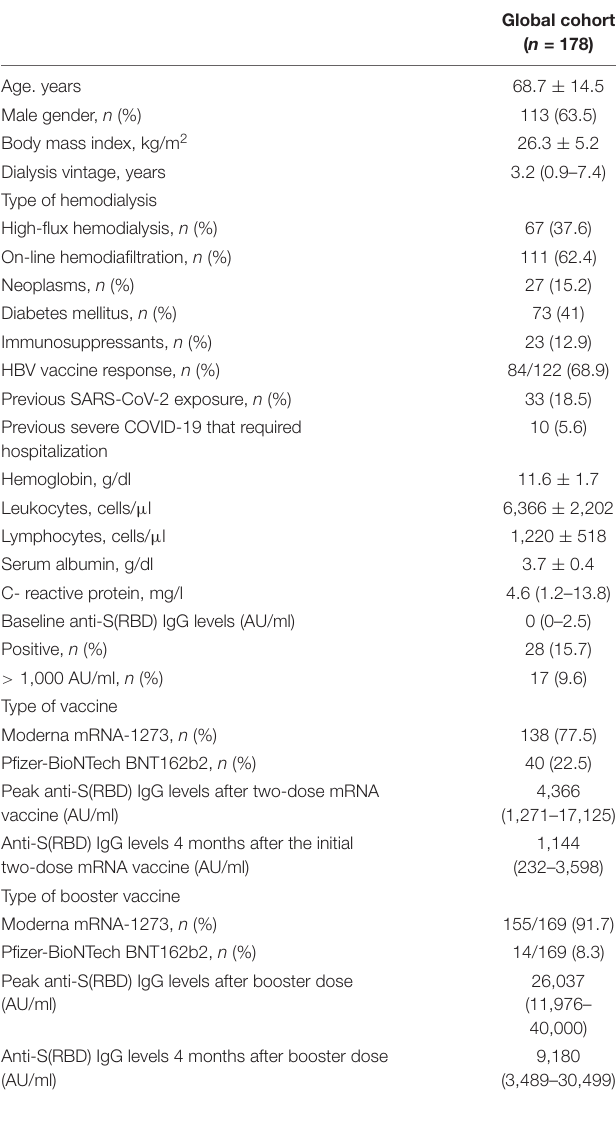
TABLE 1 | Baseline characteristics of the study population and anti-S(RBD) levels